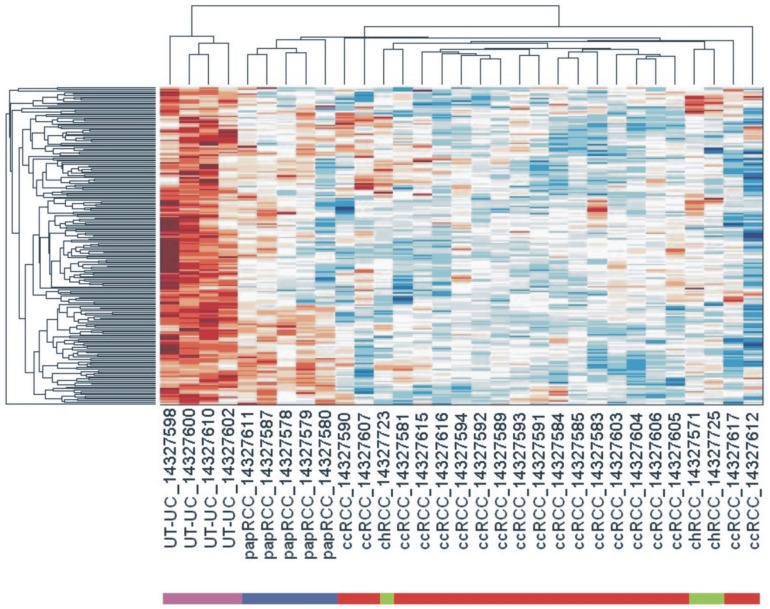
Hierarchical Clustering (HCl).The unsupervised two-way HCl with Euclidian distance depicts differential miRNA expression in ccRCC, papRCC, chRCC and UT-UC. The log2 fold change in each RCC subtype and UT-UC versus the normal kidney tissue was used to construct the heat map. miRNA profiling accurately discriminated between RCC and UT-UC, as well as among ccRCC, papRCC and chRCC. ccRCC, clear cell renal cell carcinoma; papRCC, papillary renal cell carcinoma; chRCC, chromophobe renal cell carcinoma; UT-UC, upper tract urothelial carcinoma. Red and blue colours show significant up- or down-regulation of each miRNA in the tumour versus the normal kidney, respectively.